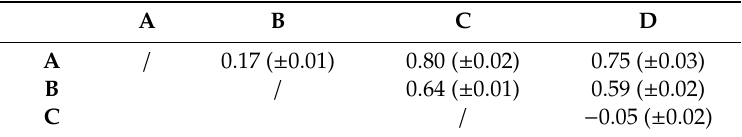
Table 2. Means of the hourly temperature di ff erences between the sites, calculated for the growing season of 2018 (15 May to 4 September). Each value is the mean di ff erence between the site in the first column and the one in the first row of the table. Values are shown in ◦ C; values in brackets represent the standard error (S.E.).